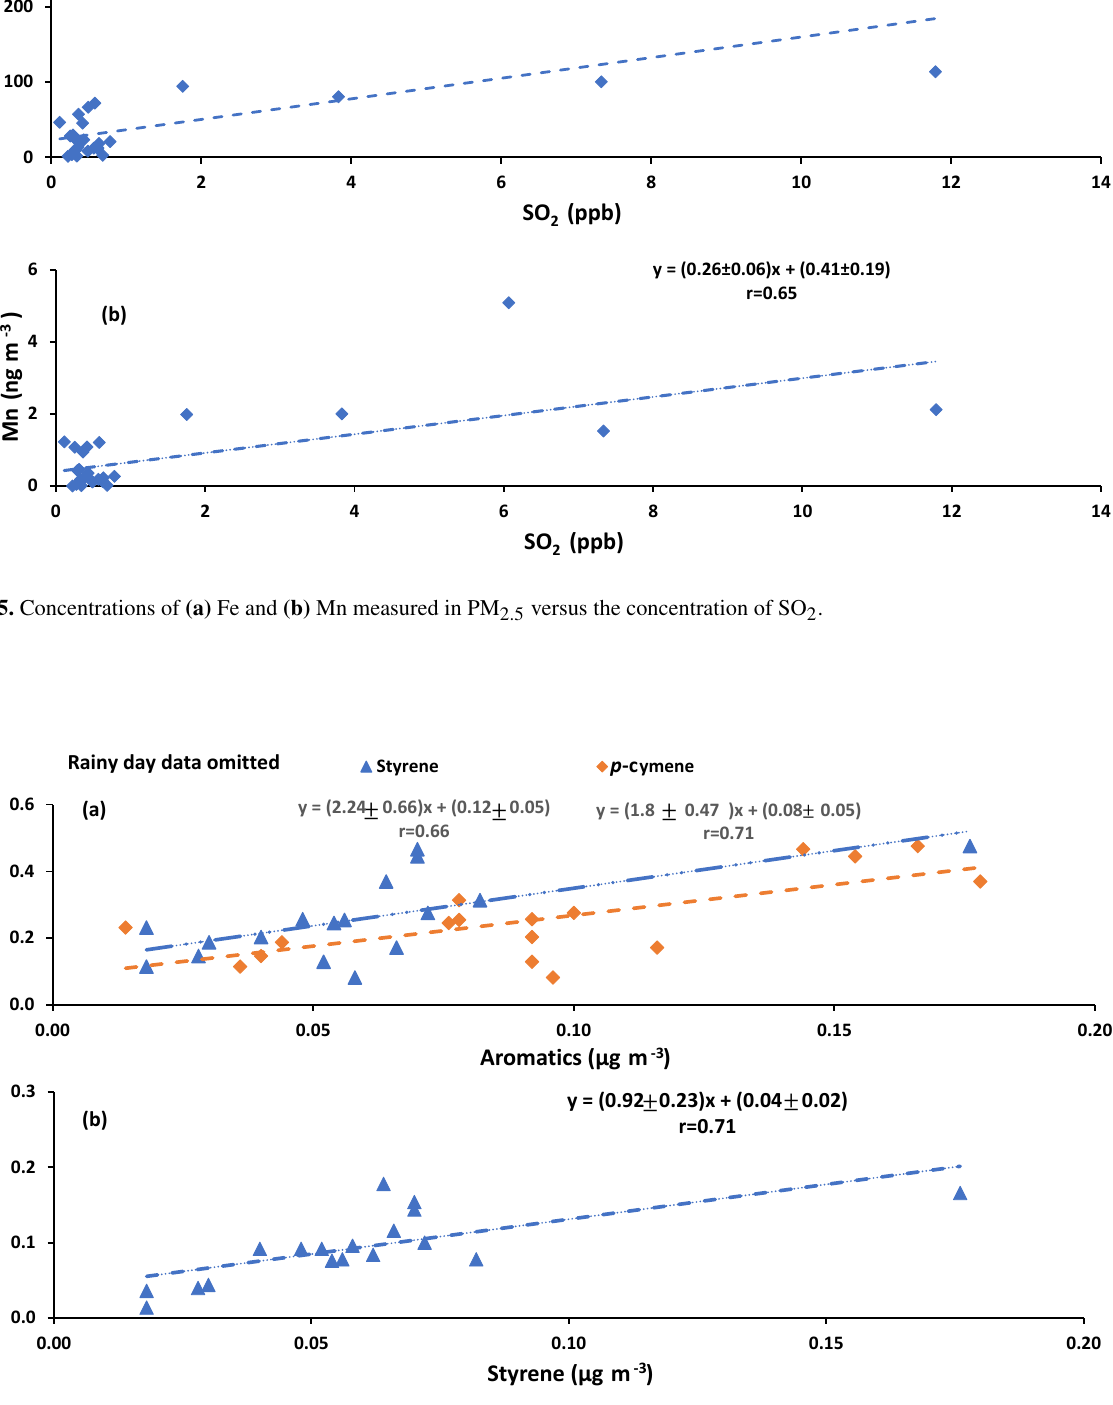
Figure A6. (a) F(s) versus the concentration of styrene and p -cymene (b) p -cymene versus